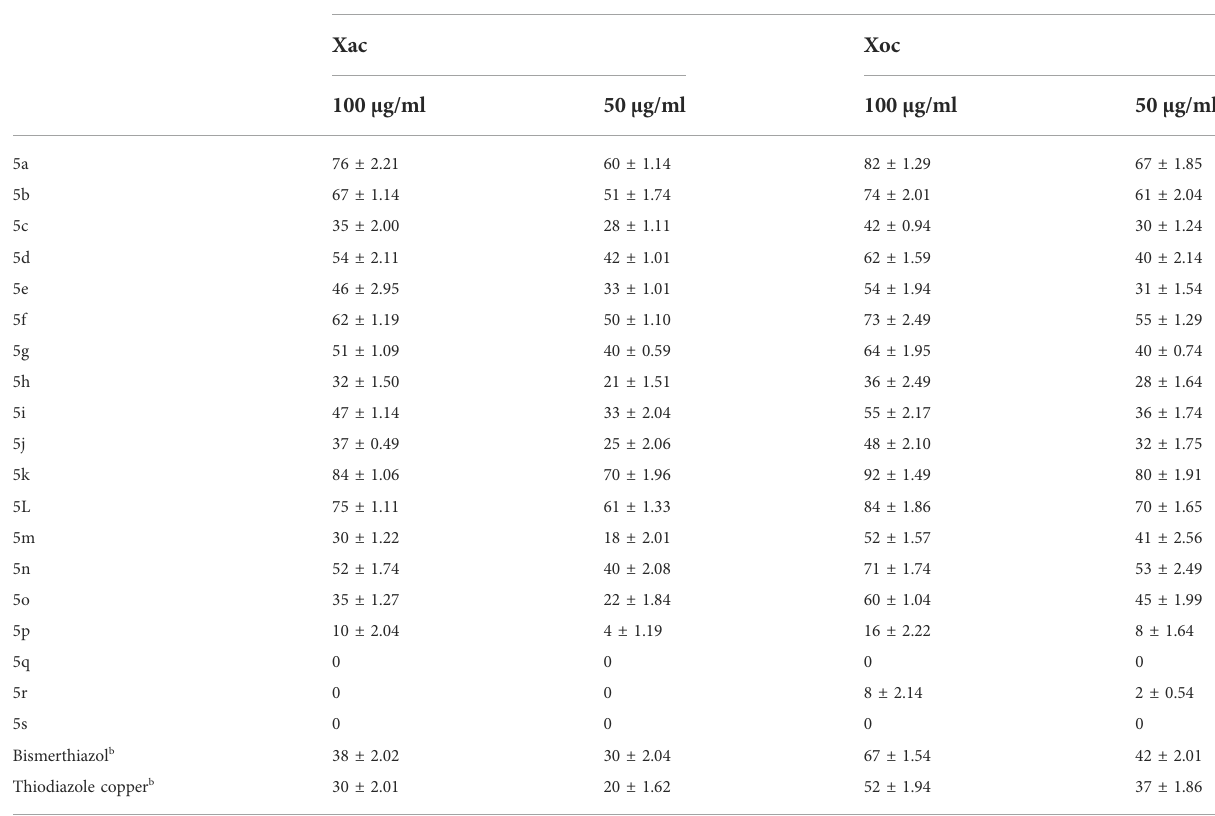
TABLE 1 In vitro antibacterial activity test of compounds 5a − 5s against Xac and Xoc. Compounds